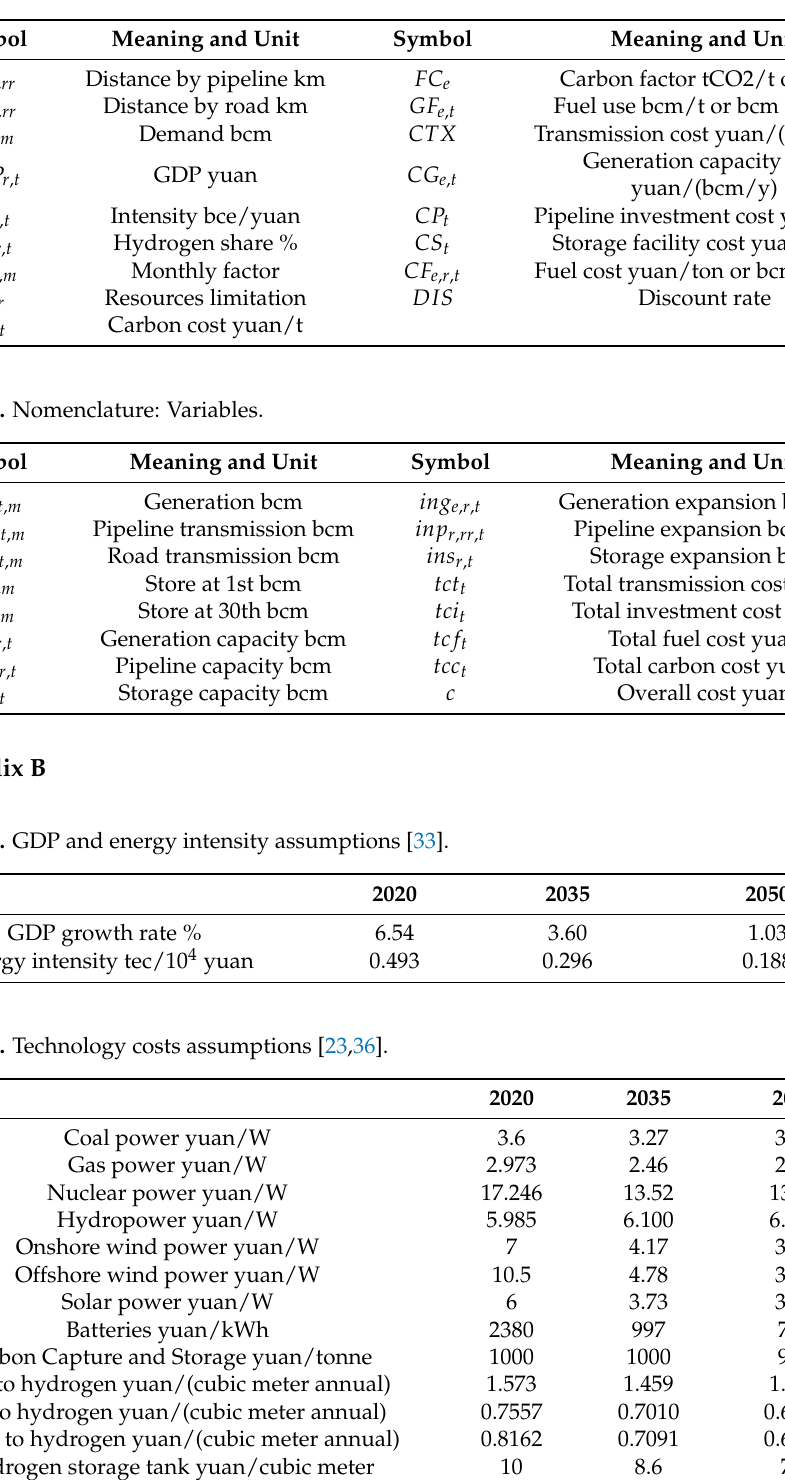
Table A2. Nomenclature: Parameters.